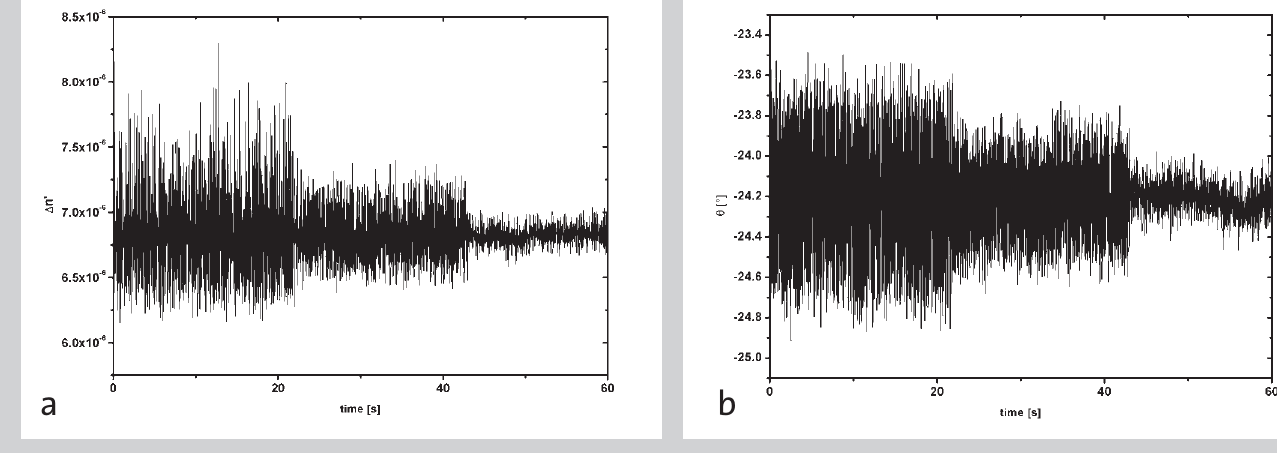
Figure 2: Comparison of the signal to noise ratio of the birefrin- gence (Figure 2a) and the orientation angle (Figure 2b) in the modified setup depending on an increasing number of points prior to the FFT (These are 512, 1024, and 2048